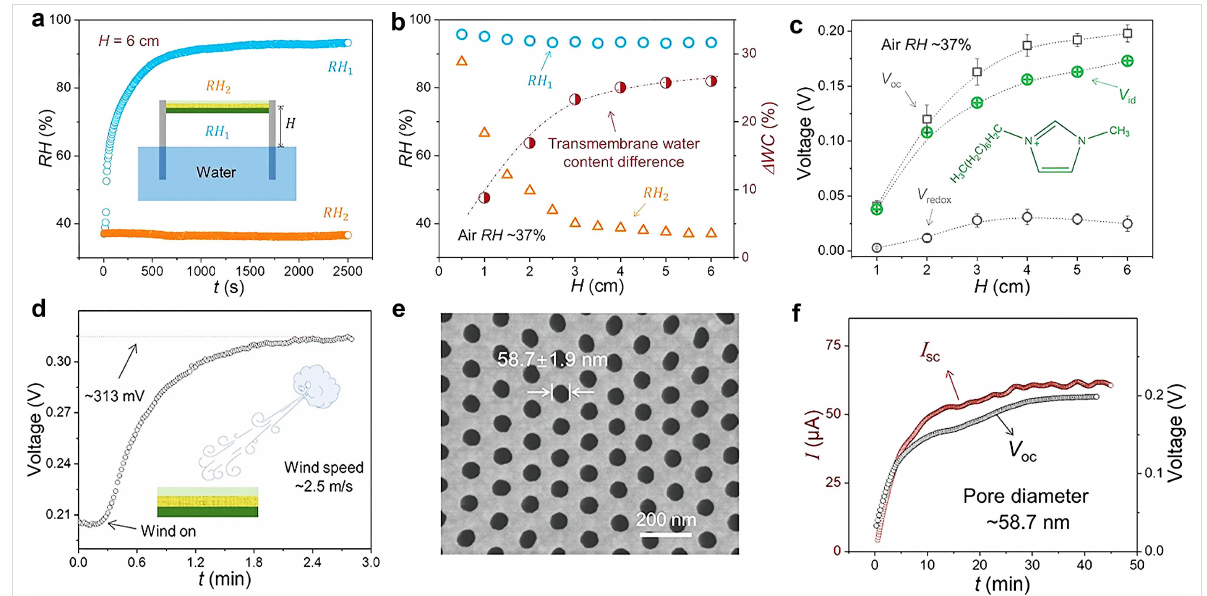
Figure 9: (a) RH at both sides of the membrane. H = 6 cm. (b) RH 1 and RH 2 as functions of H . Δ WC is the transmembrane water content difference. (c) V OC and V id as functions of H . (d) Air flow (2.5 m·s − 1 )-enhanced power generation. (e) SEM image of the prepared ion-selective membrane (pore size diameter ≈ 58.7 nm). (f) V oc and I sc as functions of the time. Figure 9a–f were reproduced from [88], Zheng, S. et al., “Continuous Energy Harvesting from Ubiquitous Humidity Gradients using Liquid-Infused Nanofluidics”, Adv. Mater., with permission from John Wiley and Sons. Copyright © 2021 WILEY-VCH GmbH. This content is not subject to CC BY 4.0.